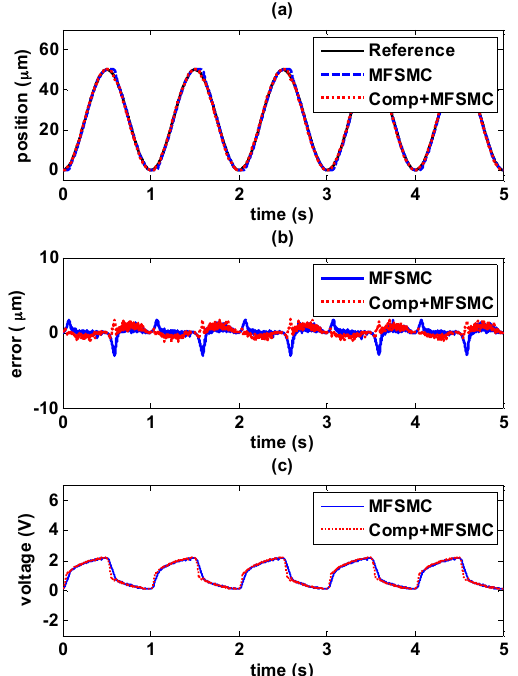
Figure 20. Tracking control comparisons of sinusoidal trajectory with 1 Hz frequency and 50 μ m amplitude between using MFSMC path controller solely and MFSMC path controller with the hysteresis compensator: ( a ) path tracking responses; ( b ) control errors; ( c ) control signals.